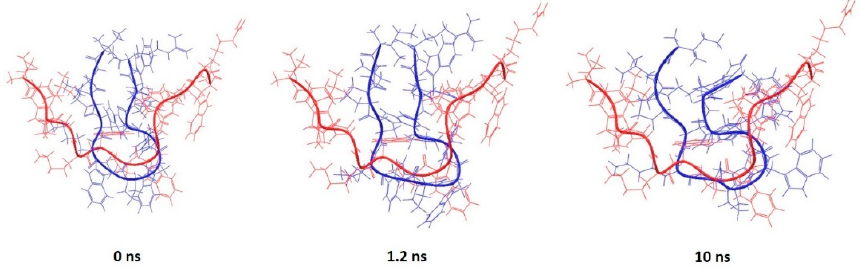
Figure 8. Backbone superposition of PDB entry 1G89 (red) and conformations at 0, 1.2 and 10 ns of MD simulation (blue).